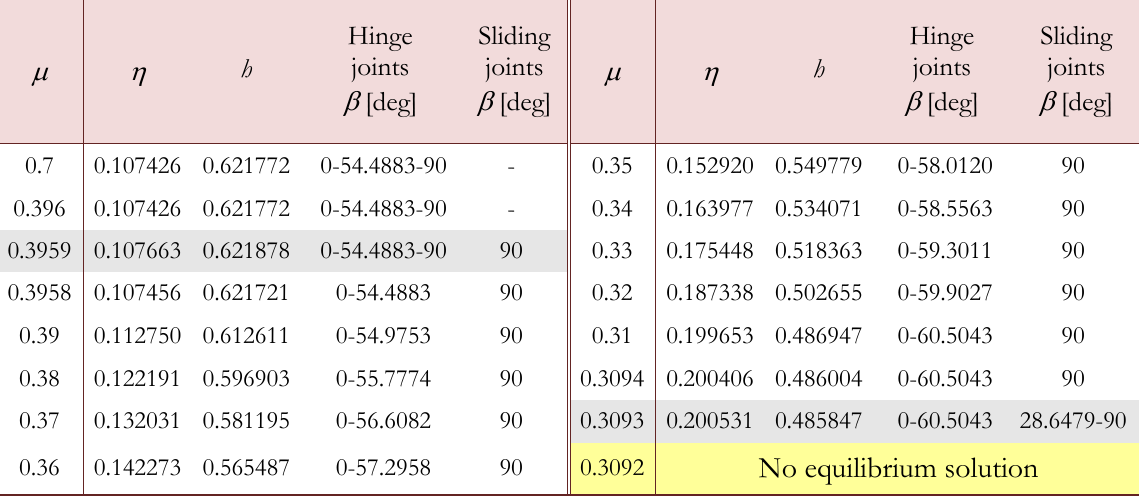
Table 2: Approximate critical solution values of triplet  , h ,  obtained for the complete semi-circular arch by the numerical analysis at variable friction coefficient 